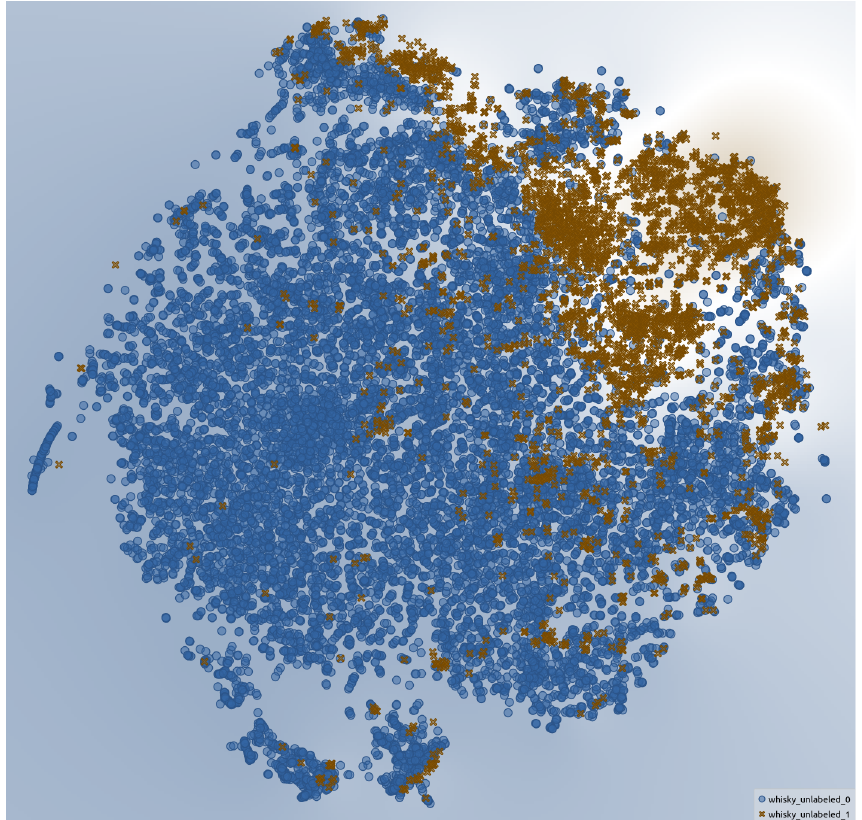
Figure 14. t-SNE representation of the words that were not annotated. A blue dot represents a word predicted as a non-descriptor, and a brown “X” represents those that are predicted as